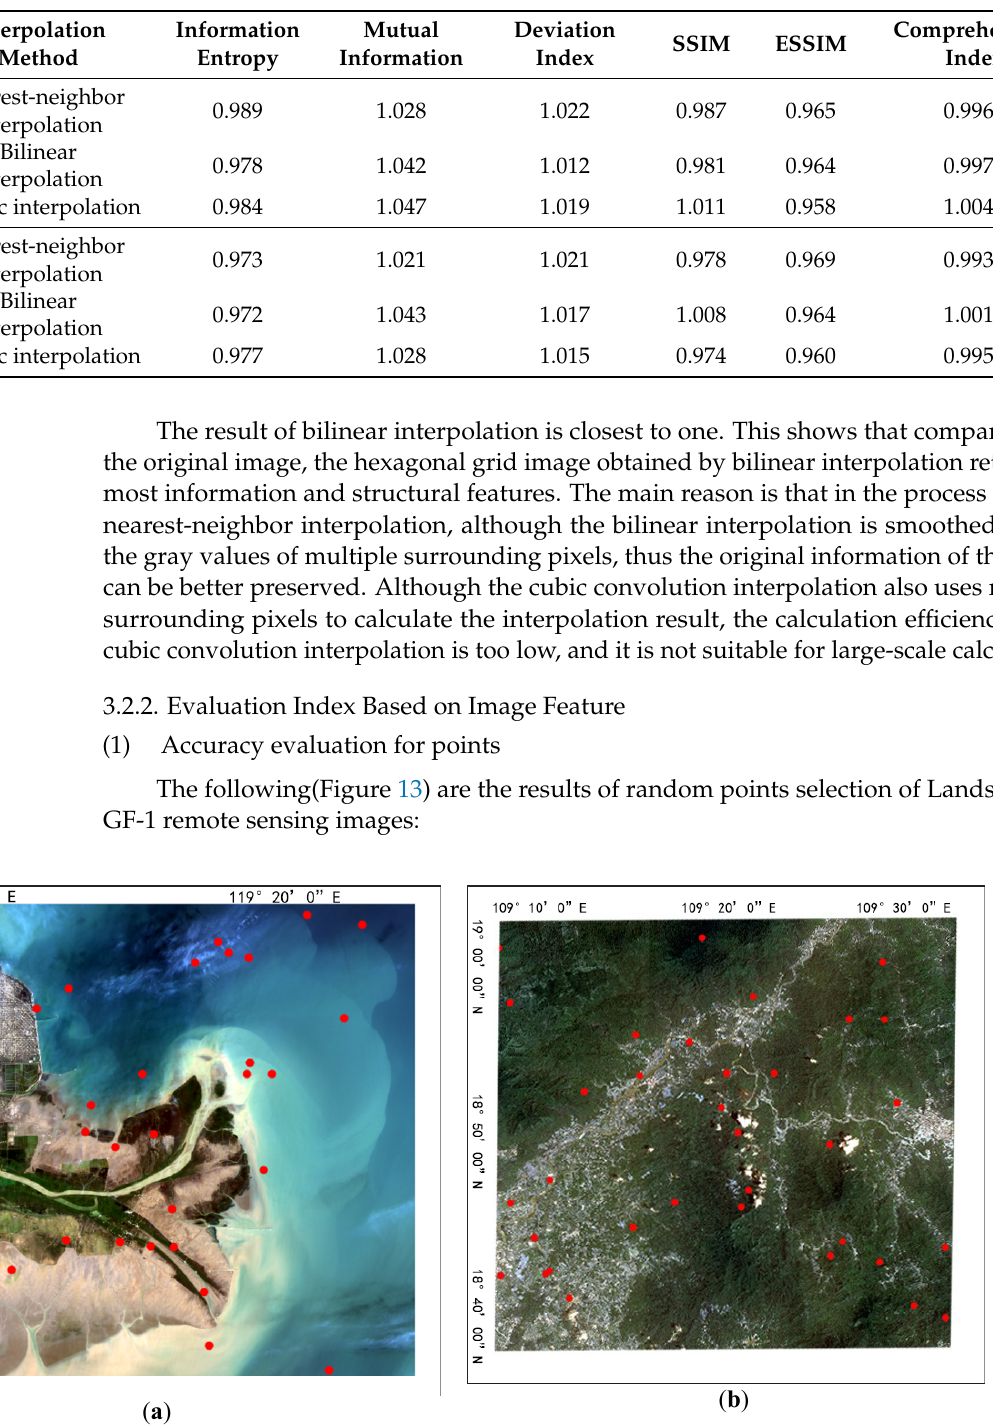
Table 6. Evaluation results based on basic evaluation indexes and image structure evaluation indexes.